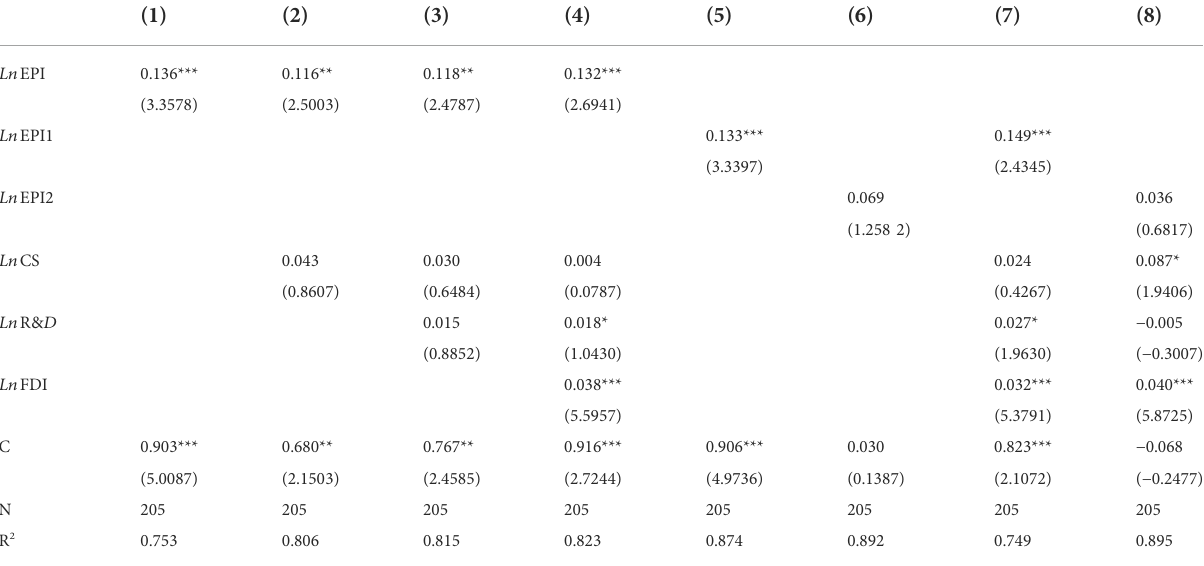
TABLE 5 Effects of EPI on the GVC position in service sectors for 41 major